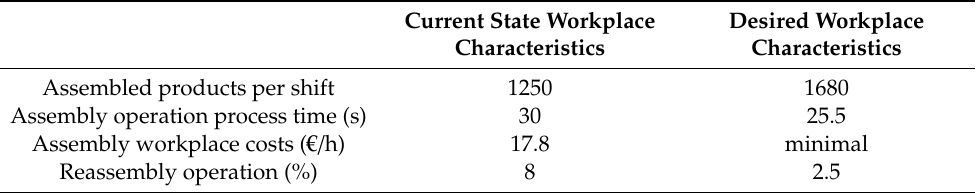
Table 1. Current and desired workplace